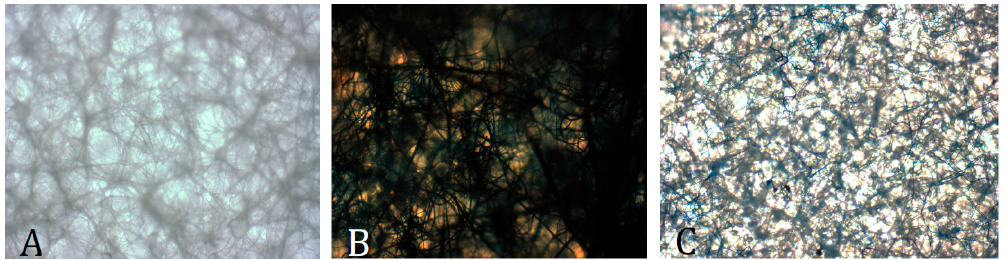
Figure 7. Fabricated PLC/Halloysite nanocomposite scaffolds loaded (and releasing) amoxicillin ( A ) Brilliant Green; ( B ) and Brilliant Green and amoxicillin ( C ). Photographed after one week. Brightfield microscopy, 4X.